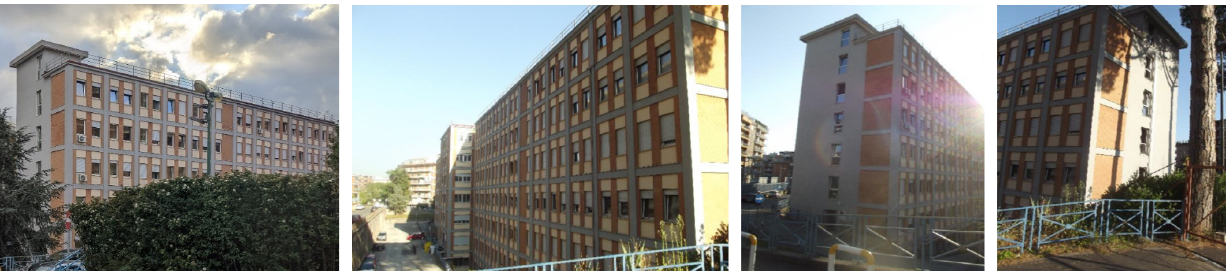
Figure 2. External photos of the Day-Hospital Building.